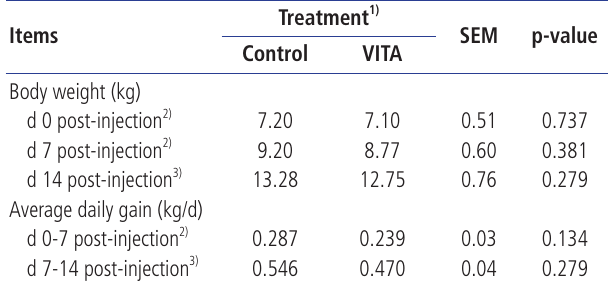
Table 2. Growth performance of pigs administered with fat-soluble vitamins